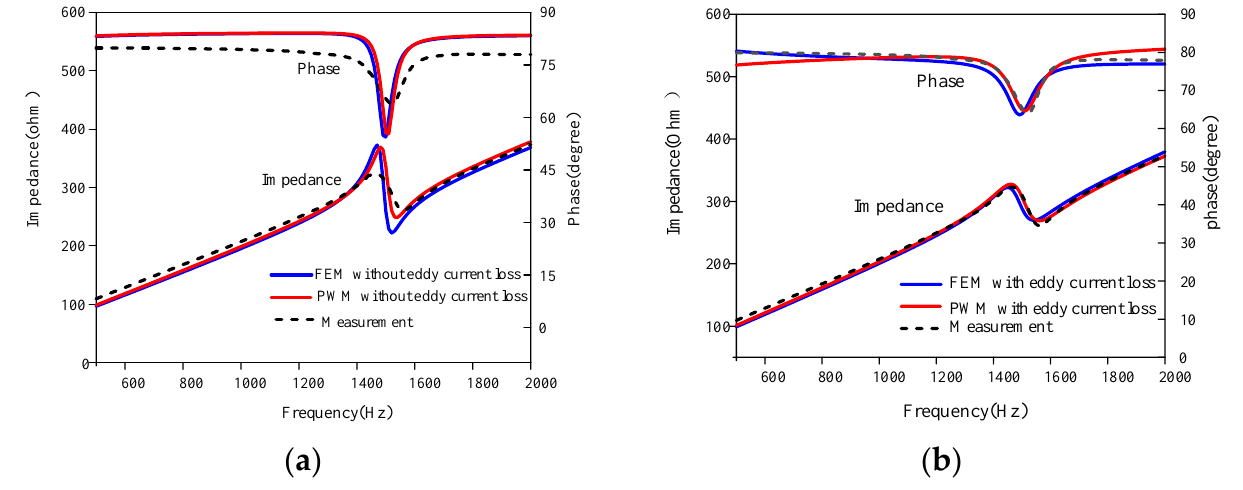
Figure 11. Impedance spectrum in air: ( a ) impedance spectrum of the simulation and experiment without considering eddy loss; ( b ) impedance spectrum of the simulation and experiment considering eddy loss.